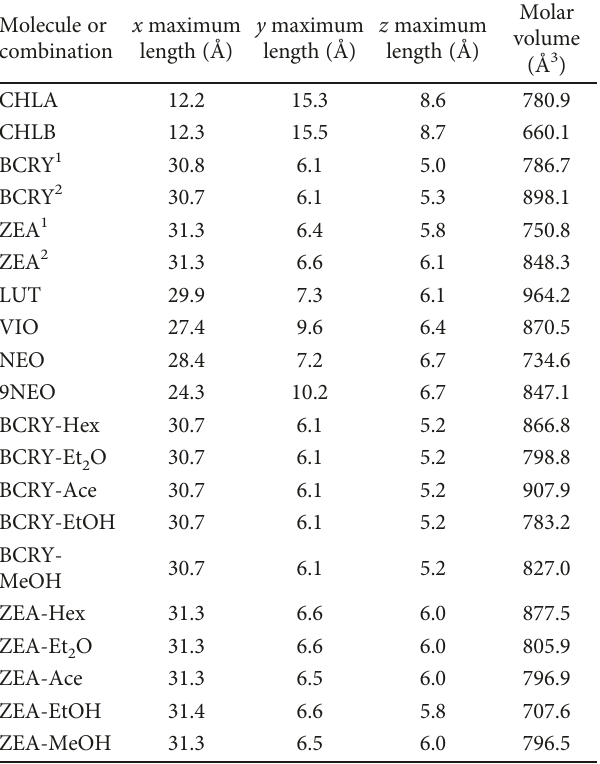
Table 1: Molecular size of pigments under study. Molecule